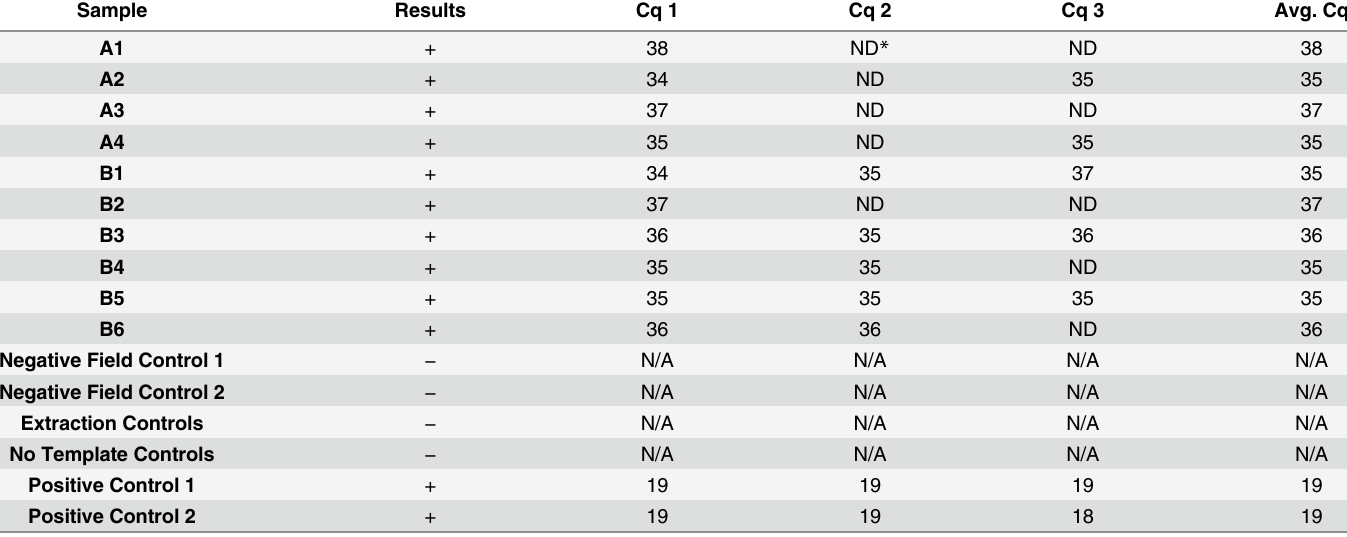
Table 1. Results of qPCR analysis for Green Sturgeon DNA ( “ + ” = positive, “ − ” = negative) at locations A and B in the Sacramento River, quantifi- cation cycle (Cq) for each technical replicate of a positive test for Green Sturgeon DNA, and average Cq across